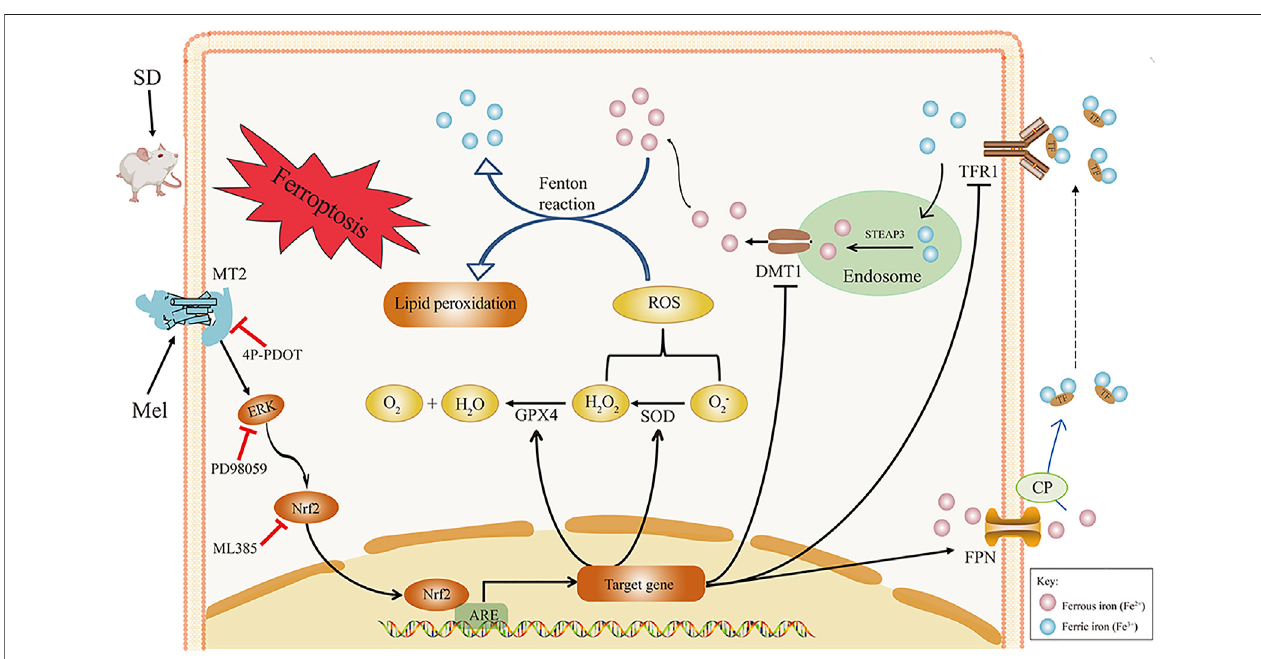
FIGURE7| HypotheticaldiagramofhowmelatoninimprovesSD-inducedhippocampalferroptosis.Exogenousmelatonin likelyalleviates hippocampal ferroptosis caused by acute SD through by binding to the MT2 receptor and activating ERK/Nrf2 signaling, thereby improving lipid peroxidation and iron transporter disorder. ARE, antioxidant response element; CP, ceruloplasmin; DMT1, divalent metal transporter 1; ERK1/2, extracellular regulated protein kinases; FPN, ferroportin; GPX4, glutathione peroxidase 4; Keap1, Kelch-like ECH-associated protein 1; Mel, melatonin; ML385, Nrf2 inhibitor; MDA, malondialdehyde; MT2, melatonin receptor 2; Nrf2,nuclearfactorerythroid2-relatedfactor2;PD98059,ERKinhibitor;ROS,reactiveoxygenspecies;SD,sleepdeprivation;SOD,superoxidedismutase;STEAP3,6- transmembrane epithelial antigen of the prostate 3; TFR1, transferrin receptor 1; 4P-PDOT, 4-phenyl-2-propionamidotetralin.